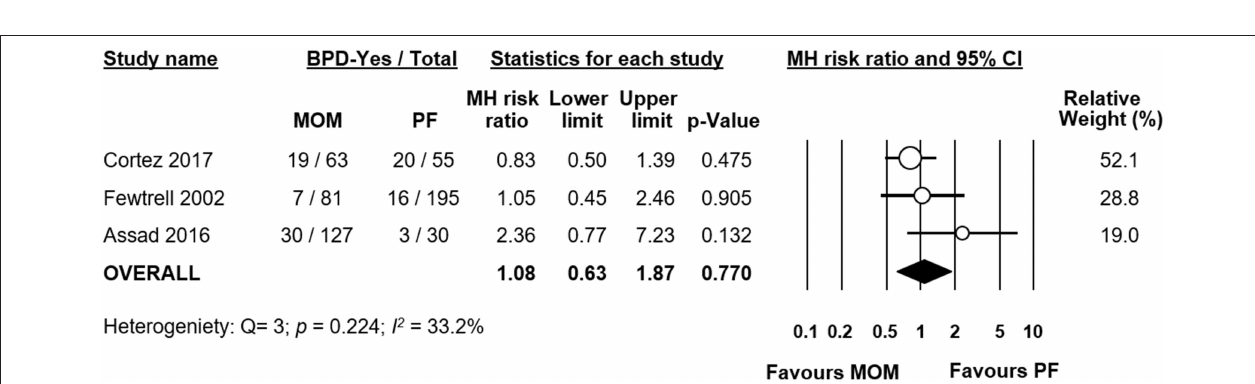
FIGURE 3 | Meta-analysis of exclusive MOM vs. exclusive PF and risk of BPD. MOM, mother’s own milk; PF, preterm formula; BPD, bronchopulmonary dysplasia; CI, confidence interval; MH, Mantel-Haenszel.